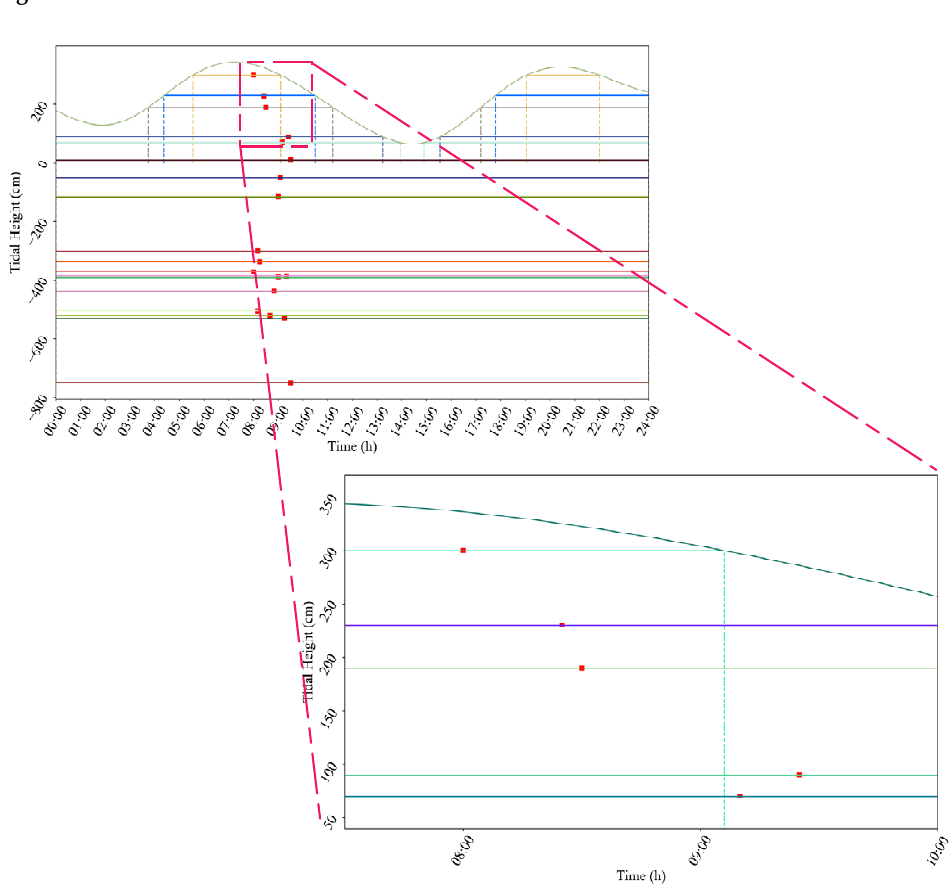
Figure 10. Ship navigable time window under the constraint of tide height.